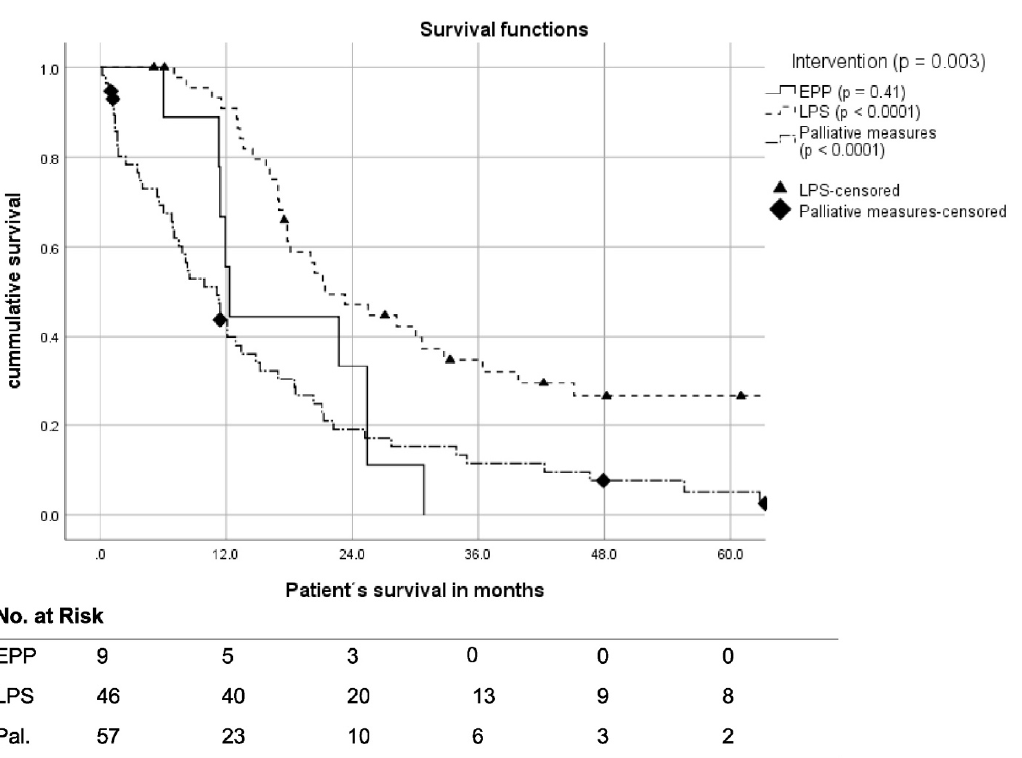
Figure 3. Kaplan–Meier curves of patient survival according to the therapy regimen received. EPP extrapleural pneumonectomy, LPS lung-preserving surgery, Pal. palliative measures. The median OS in tumor Stage I was 42.3 months (95% CI: 17.8–66.8), while it was 18.1 months in Stage II (95% CI: 16.0–20.2), 17.4 months in Stage III (95% CI: 15.1–19.7) and 8.5 months (95% CI: 5.0–9.0) in Stage IV; these differences were statistically significant ( p < 0.001) (Figure 4).